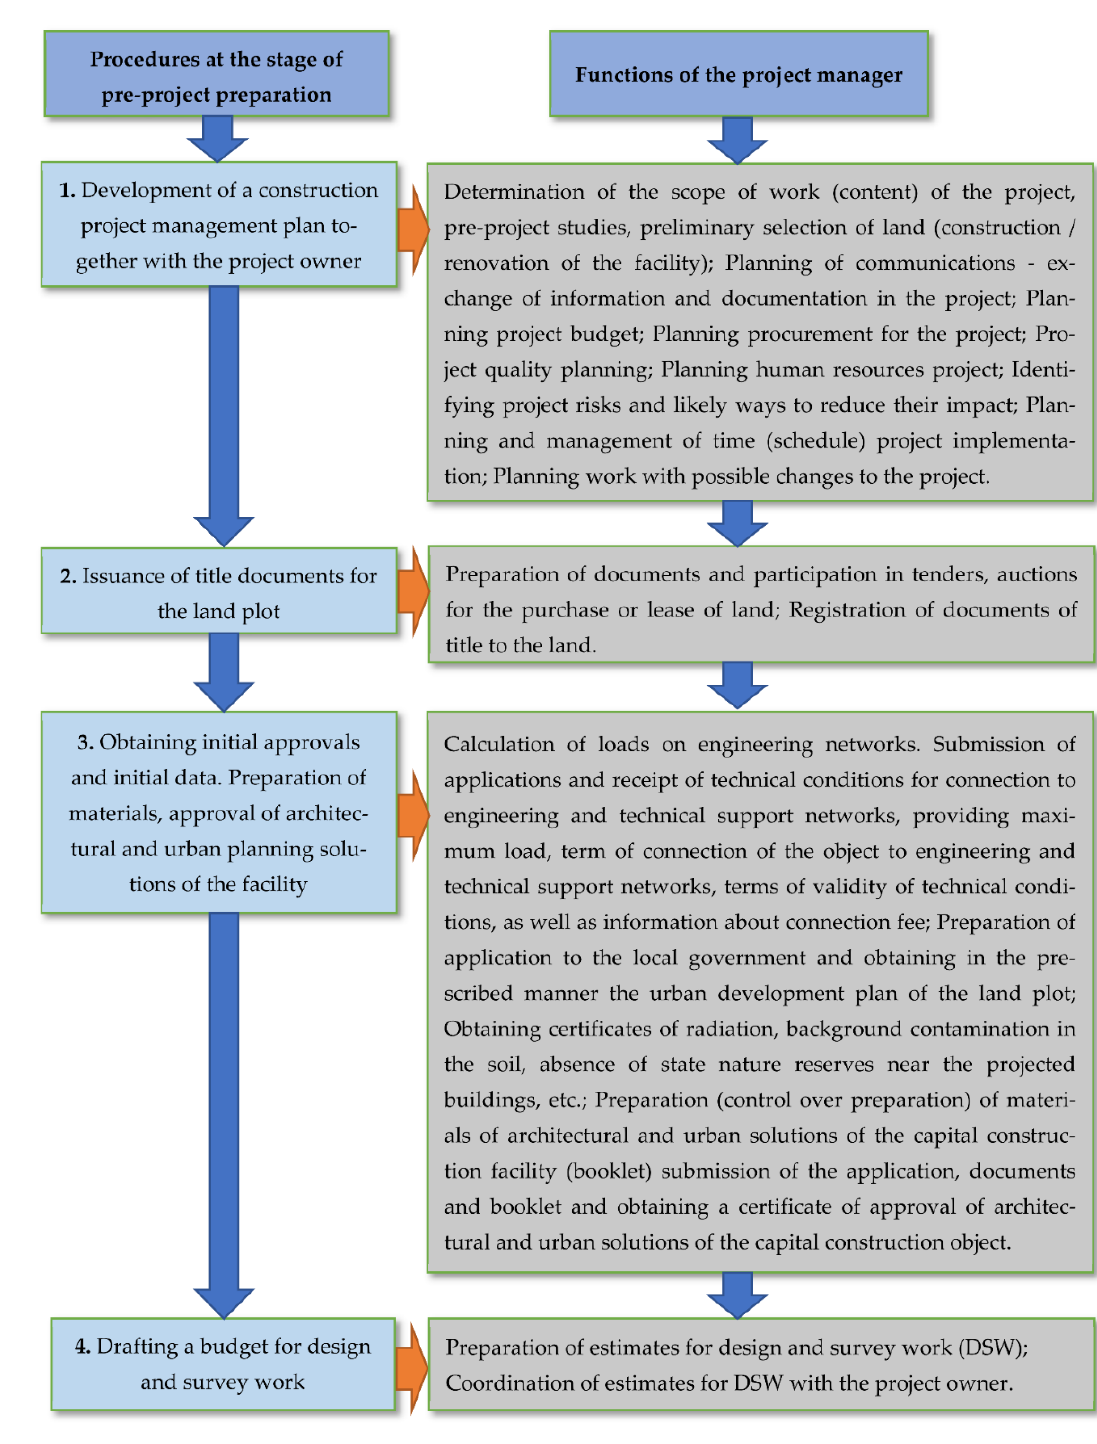
Figure 7. Consolidated procedures and functions of the project manager at the stage of pre-project preparation of a facility for construction. Part